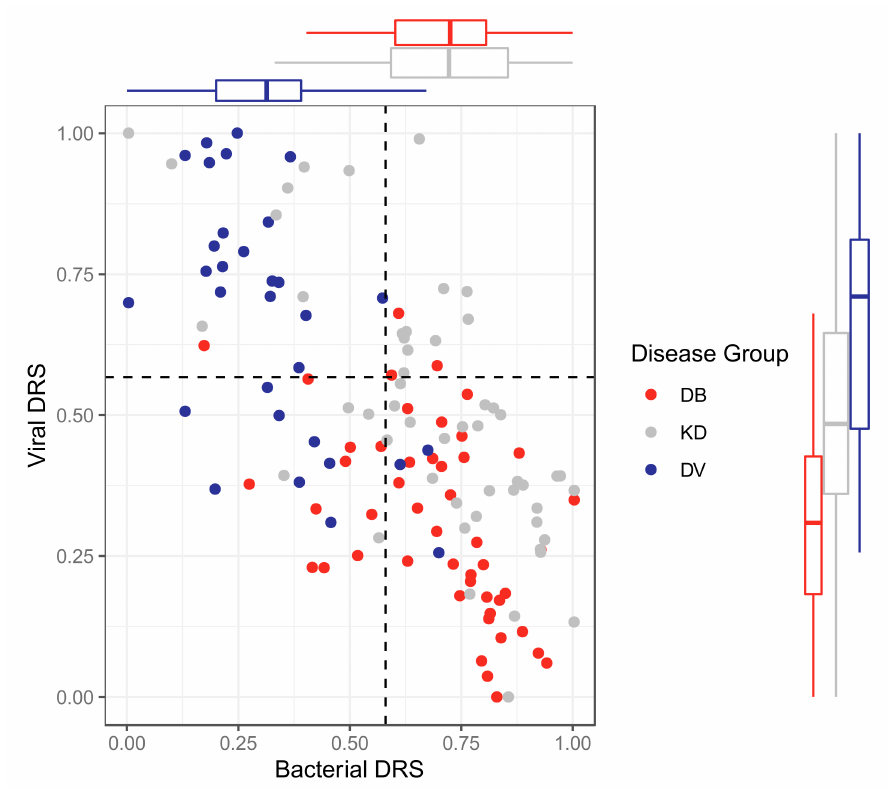
Figure 5. Bacterial DRS (DB-DRS) plotted against viral DRS (DV-DRS) for KD (discovery and validation), DB (from the validation cohort) and DV (from the validation cohort) patients from the proteomic datasets. Boxplots are shown for each disease group. KD, DB and DV represent Kawasaki Disease, definite bacterial, and definite viral,